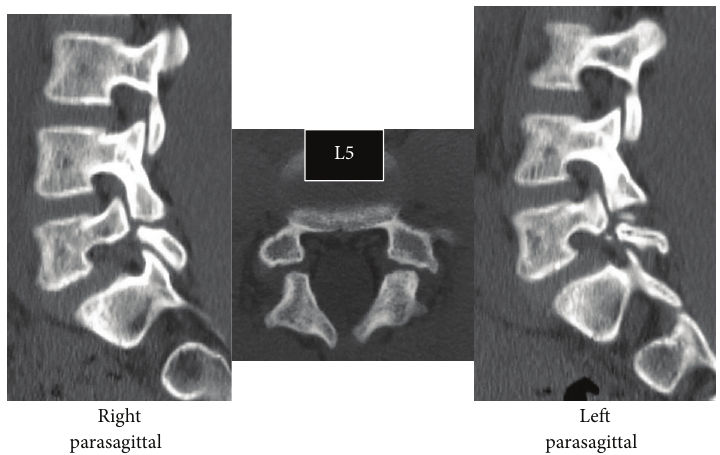
Figure 3: CT of Case 1. L5 spondylolysis is considered to be at the terminal stage (i.e., pseudoarthrosis).